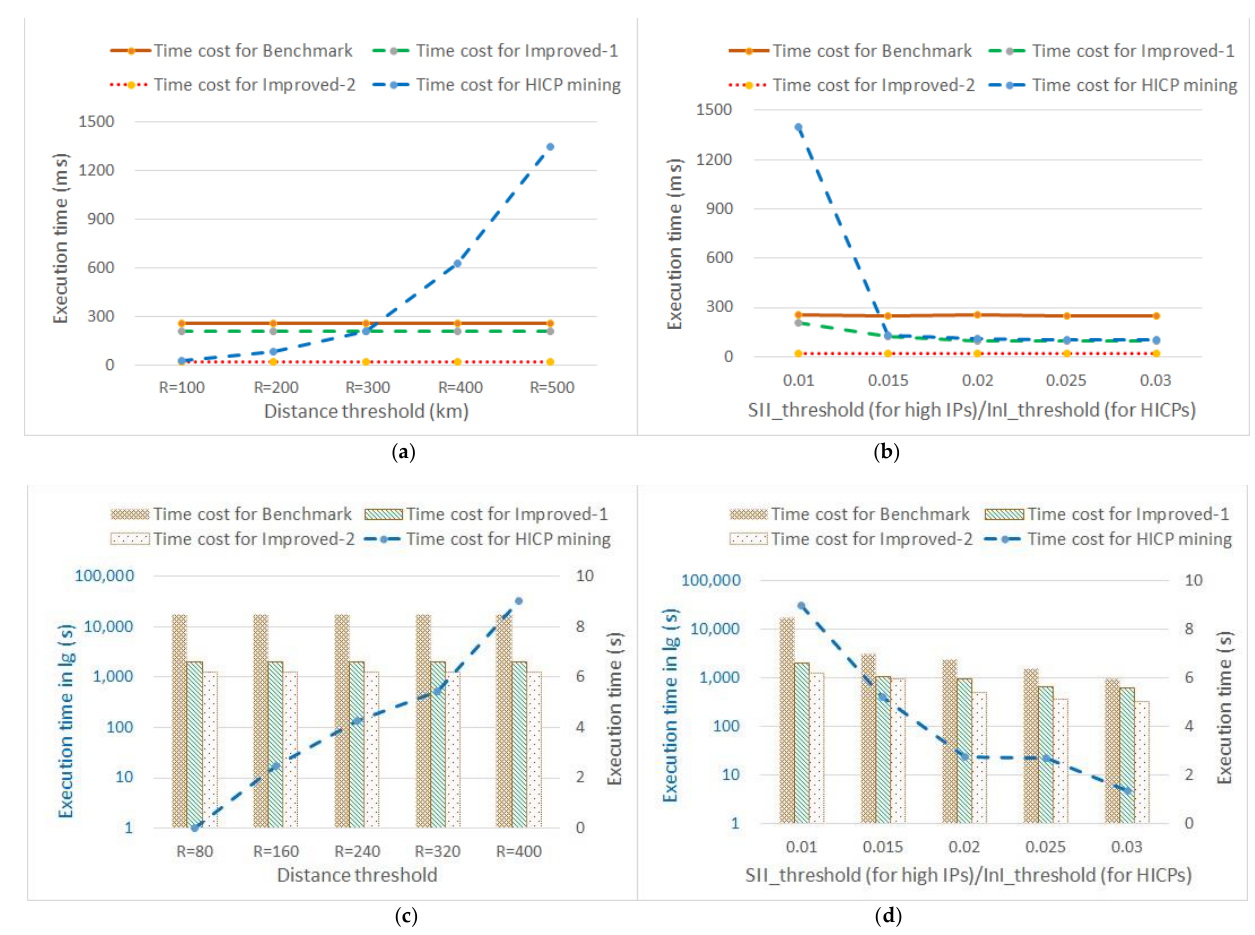
Figure 8. ( a ) Effect of distance threshold on efficiency (over the Real-1 dataset); ( b ) effect of SII threshold /InI threshold on efficiency (over the Real-1 dataset); ( c ) effect of distance threshold on efficiency (over the Syn-1 dataset); ( d ) effect of SII threshold /InI threshold on efficiency (over the Syn-1 dataset).